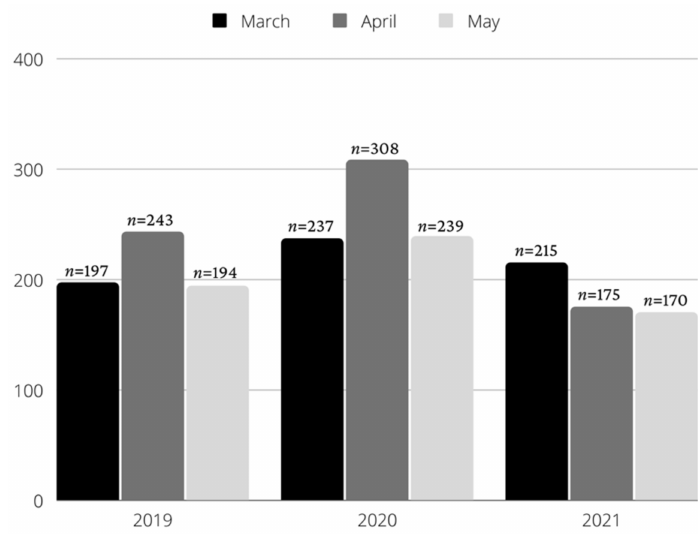
Figure 1. Evolution in 2019, 2020, and